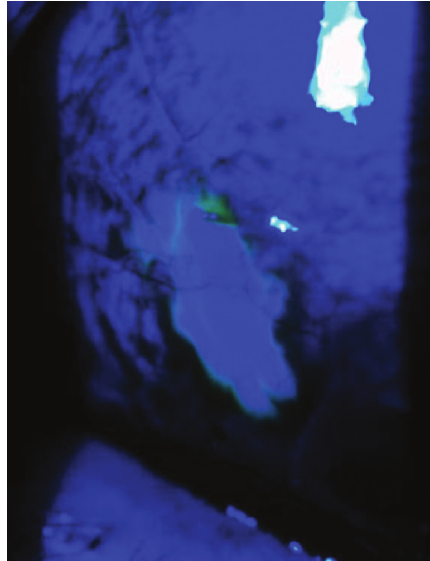
Figure 5: Complications of XEN implantation—bleb leakage.